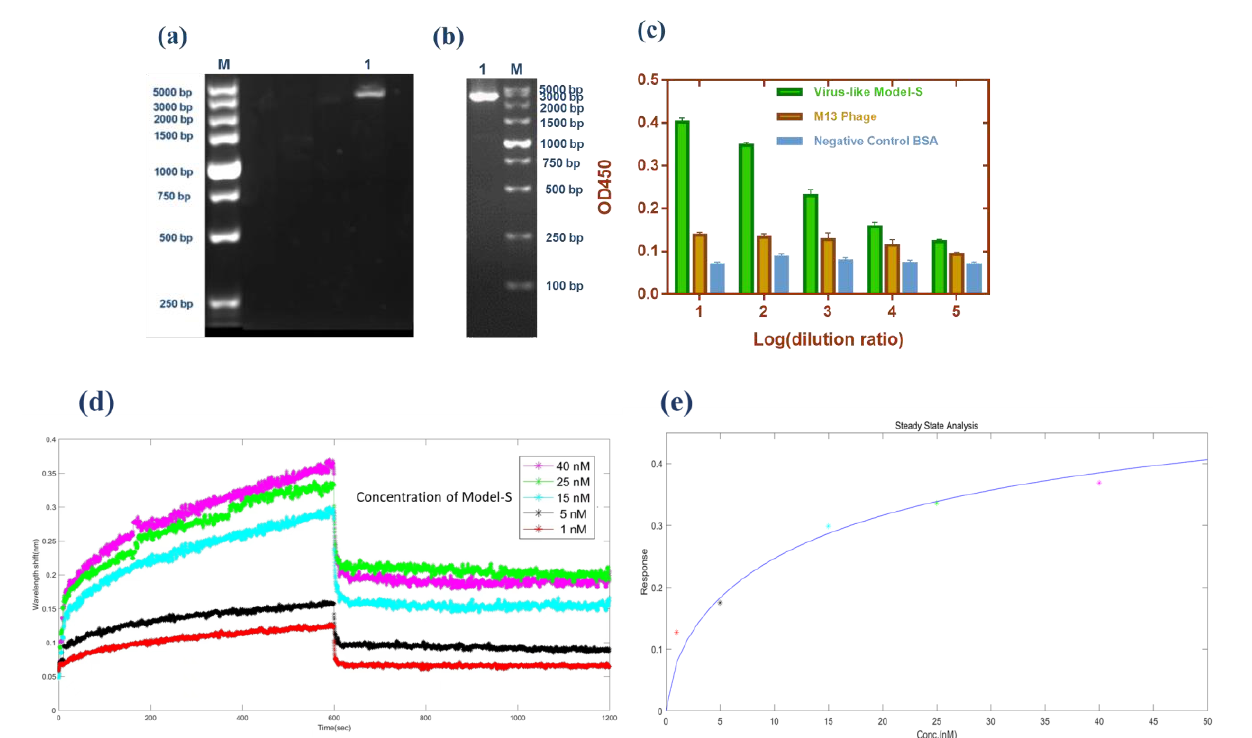
Figure 1. Validation of the Model-S. ( a ) Double digestion (SfiI/NotI) of pHB-S. Lane M: